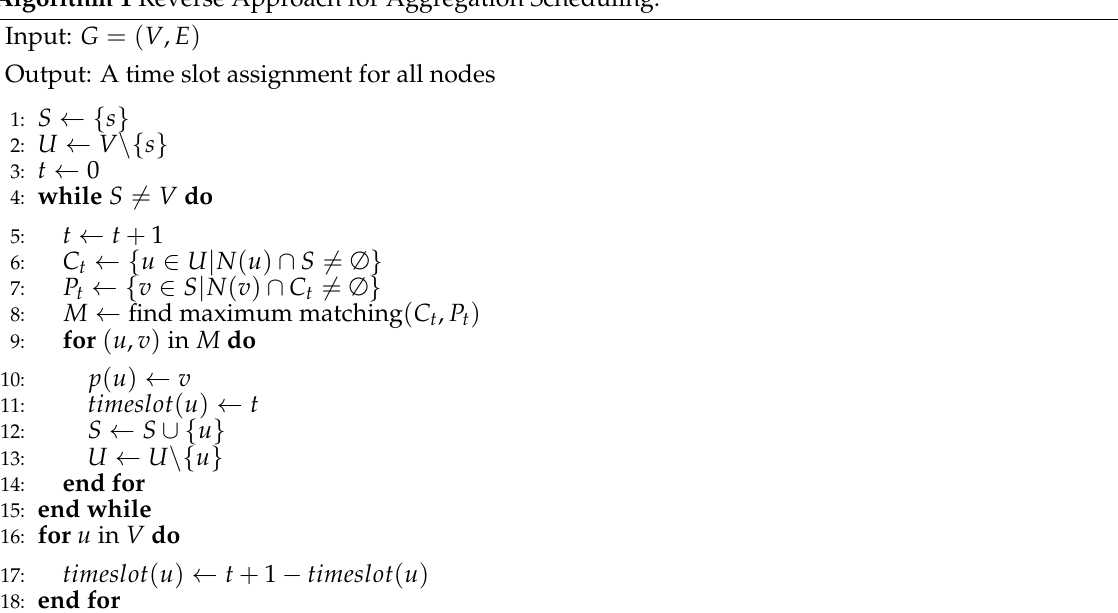
Algorithm 1 Reverse Approach for Aggregation